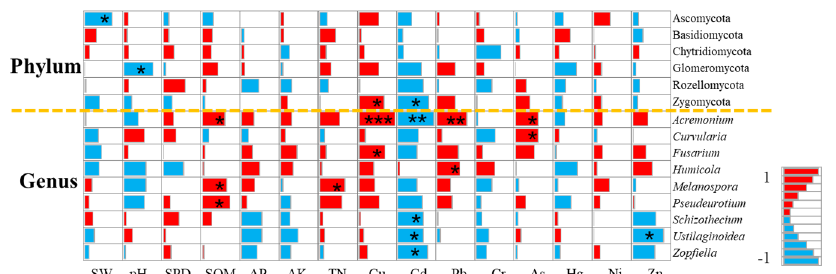
Figure 15. Correlation between soil environmental factors and fungal community structure at lightly polluted levels of heavy metals. (Note: In the figure, warm colors indicate positive correlation, and cool colors indicate negative correlation. *, **, *** indicate significant correlation at the levels of 0.05, 0.01, and 0.001, respectively).